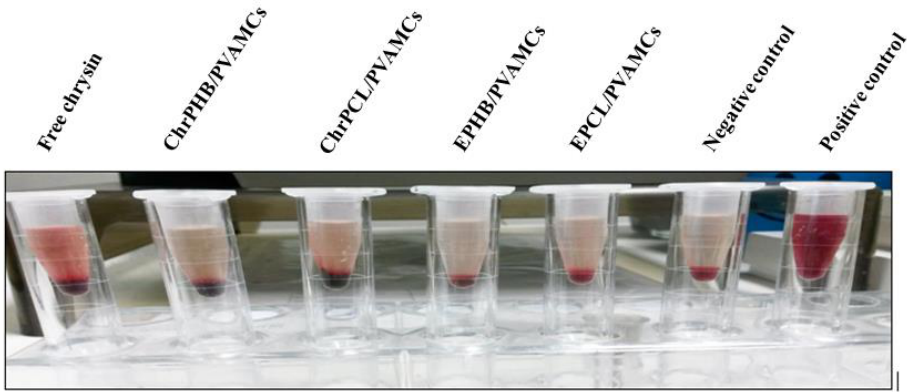
Figure 9. Micrograph of human RBCs showing the degree of hemolysis after incubation with 500 µ g · mL − 1 of free chrysin, ChrPHB/PVAMCs, ChrPCL/PVAMCs, EPHB/PVAMCs, and EPCL/PVAMCs.